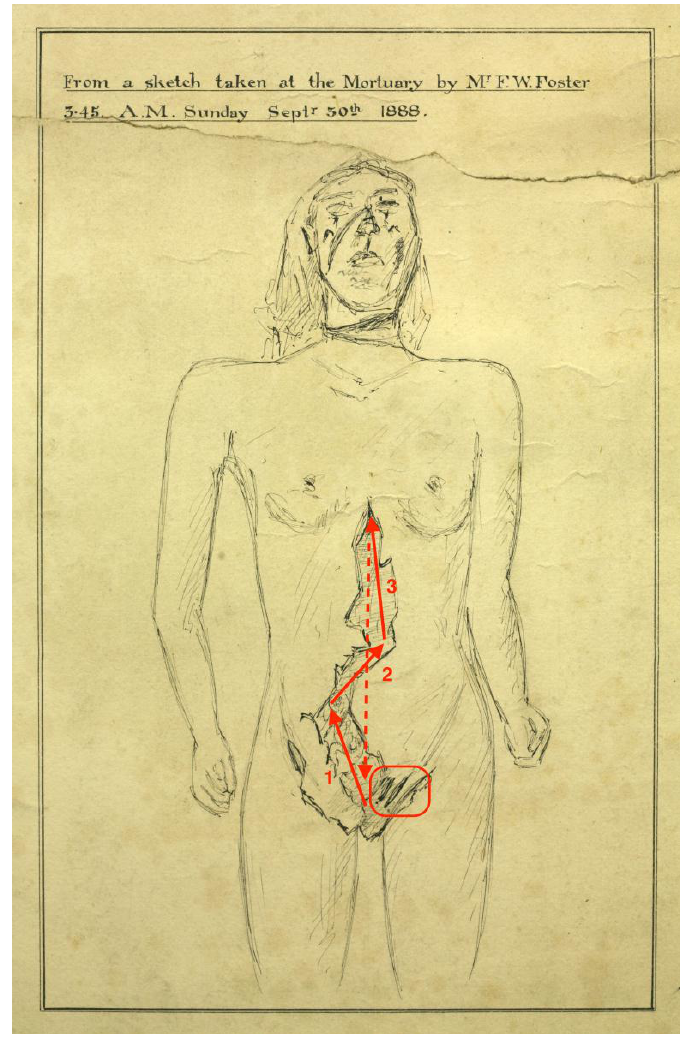
Figure 1. Analysis of wounds inflicted on Catherine Eddowes (From a sketch by Frederick William Foster, presented at the inquest held on 6 October 1888. Reproduced by permission of the Royal London Hospital Archives and Museum (Accession reference: RLHT1997/42). We have added locations of the exploratory incisions, along with the three primary incisions (solid) and the normal location and direction of the abdominal incision used for organ procurement (dashed) [7] (p. 21)).